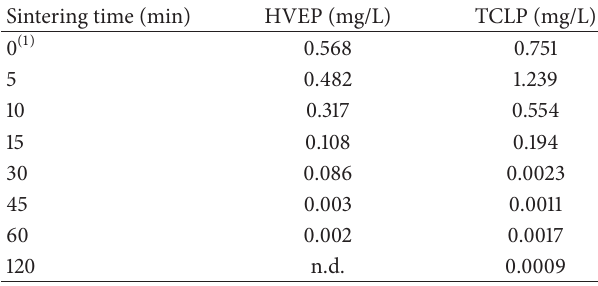
Table 4: The As leaching concentration of sintered products for different sintering times.